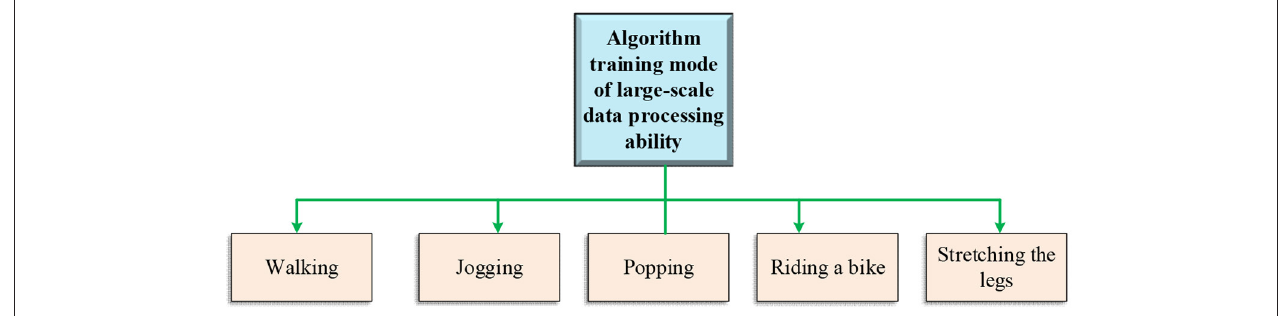
FIGURE 6 | Training mode of large-scale data processing ability algorithm.